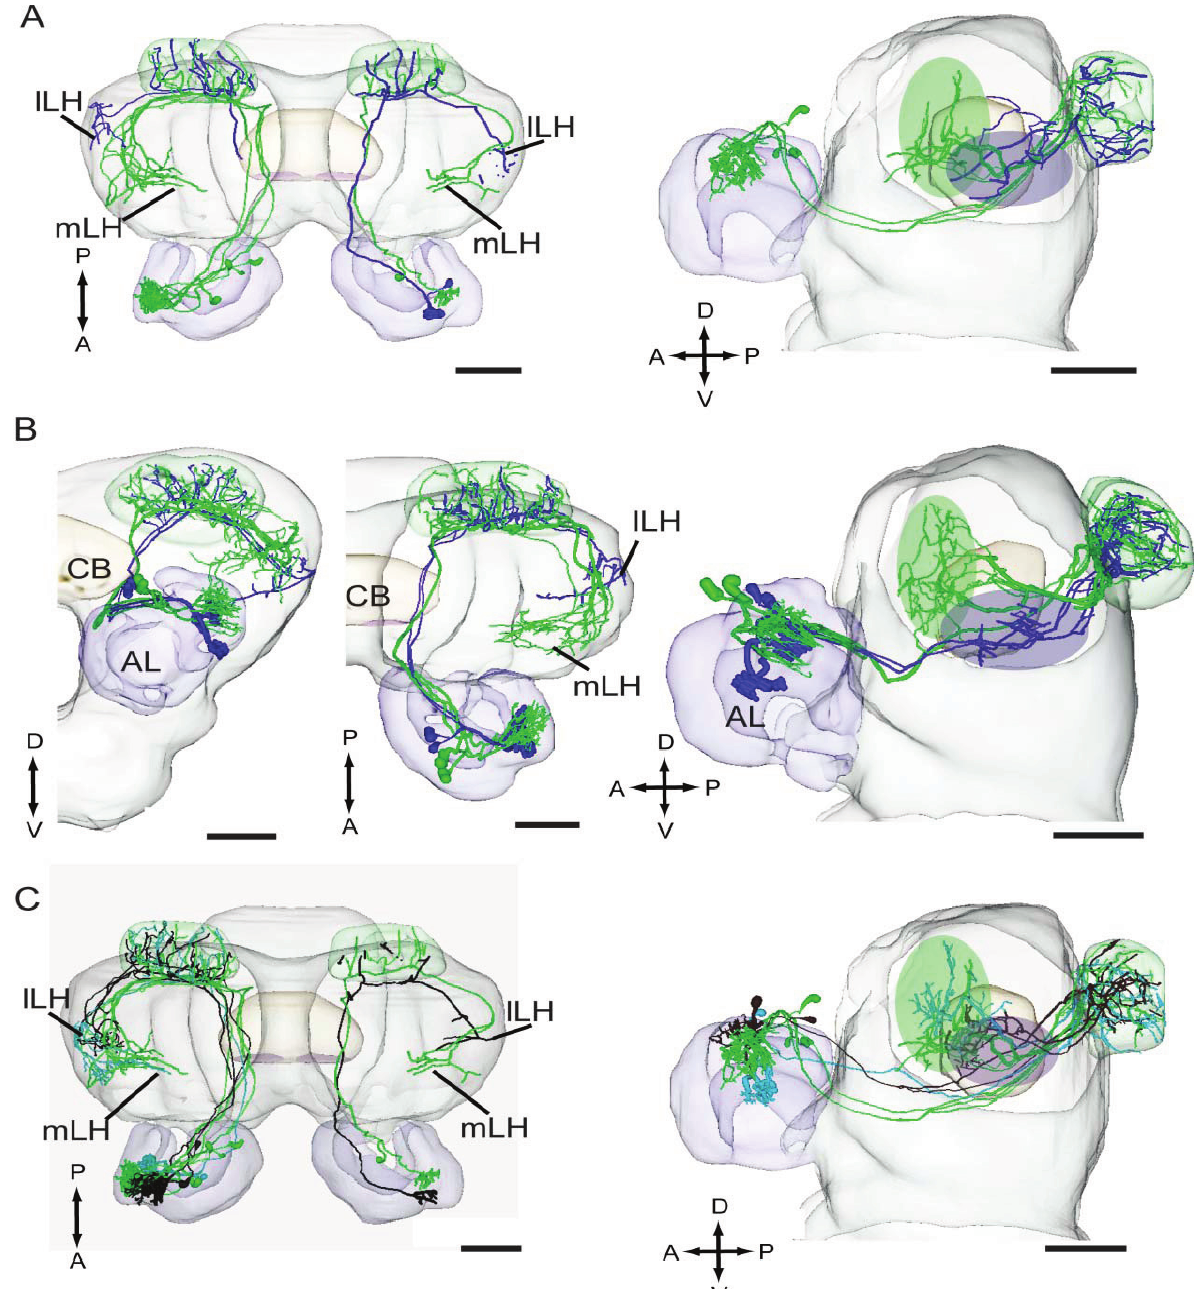
Figure 2. Digital reconstructions of individual medial-tract projection neurons obtained from males of Heliothis assulta and Heliothis virescens, which have been integrated into standard brain atlases of the respective species, adapted from Zhao et al . [89]. ( A , B ) Both in H. assulta and H. virescens , the projection neurons tuned to plant odors (blue) and pheromones (green) terminate in non-overlapping regions of the lateral horn (LH). ( C ) In H. assulta , the two projection neuron categories carrying pheromone information (green and turquoise) target a completely overlapping region of the LH, whereas the neurons tuned to the interspecific signal (black) target a smaller and partly differently located area. lLH, lateral part of the lateral horn; mLH, medial part of the lateral horn; CB, central body; AL, antennal lobe; P, posterior; A, anterior; D, dorsal; V, ventral. Scale bars: 100